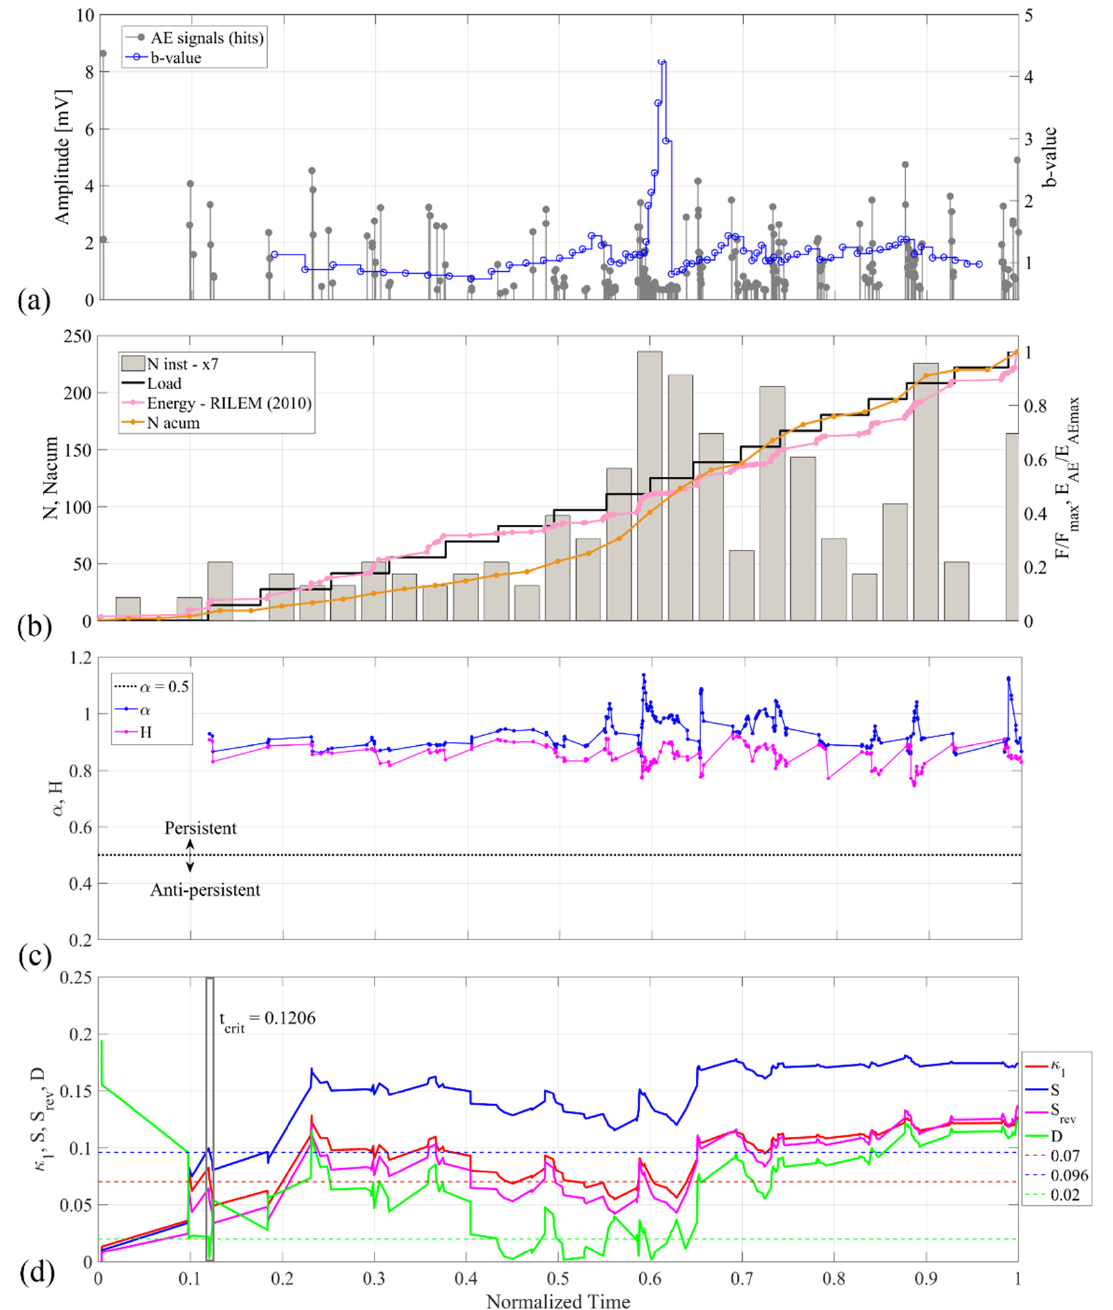
Figure 14. ( a ) The AE signals and corresponding b -values for the spaghetti bridge loading test, as described in [27]); ( b ) The numbers of instantaneous signals, the number of accumulated signals, the applied load, and the accumulated energy versus normalized time. The first was multiplied by 7 to maintain the same vertical scale for instantaneous and accumulated signals; ( c ) The application of Hurst and DFA methods to the AE data; ( d ) NT analysis of the AE time series (this figure’s format follows that of Figure 7d).